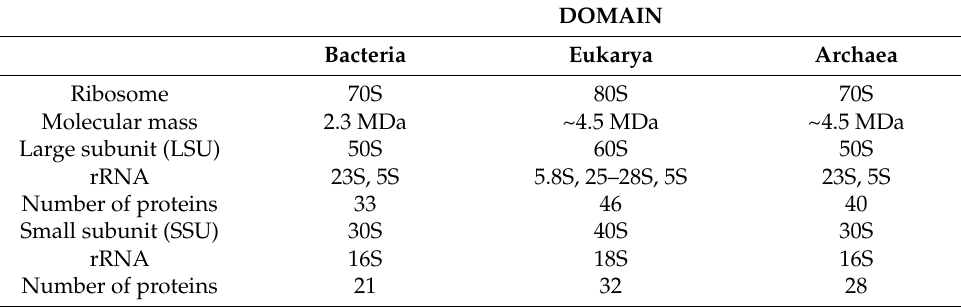
Table 1. Ribosome composition in each domain of life [4,7,8]. DOMAIN Bacteria Eukarya Archaea Ribosome 70S 80S 70S Molecular